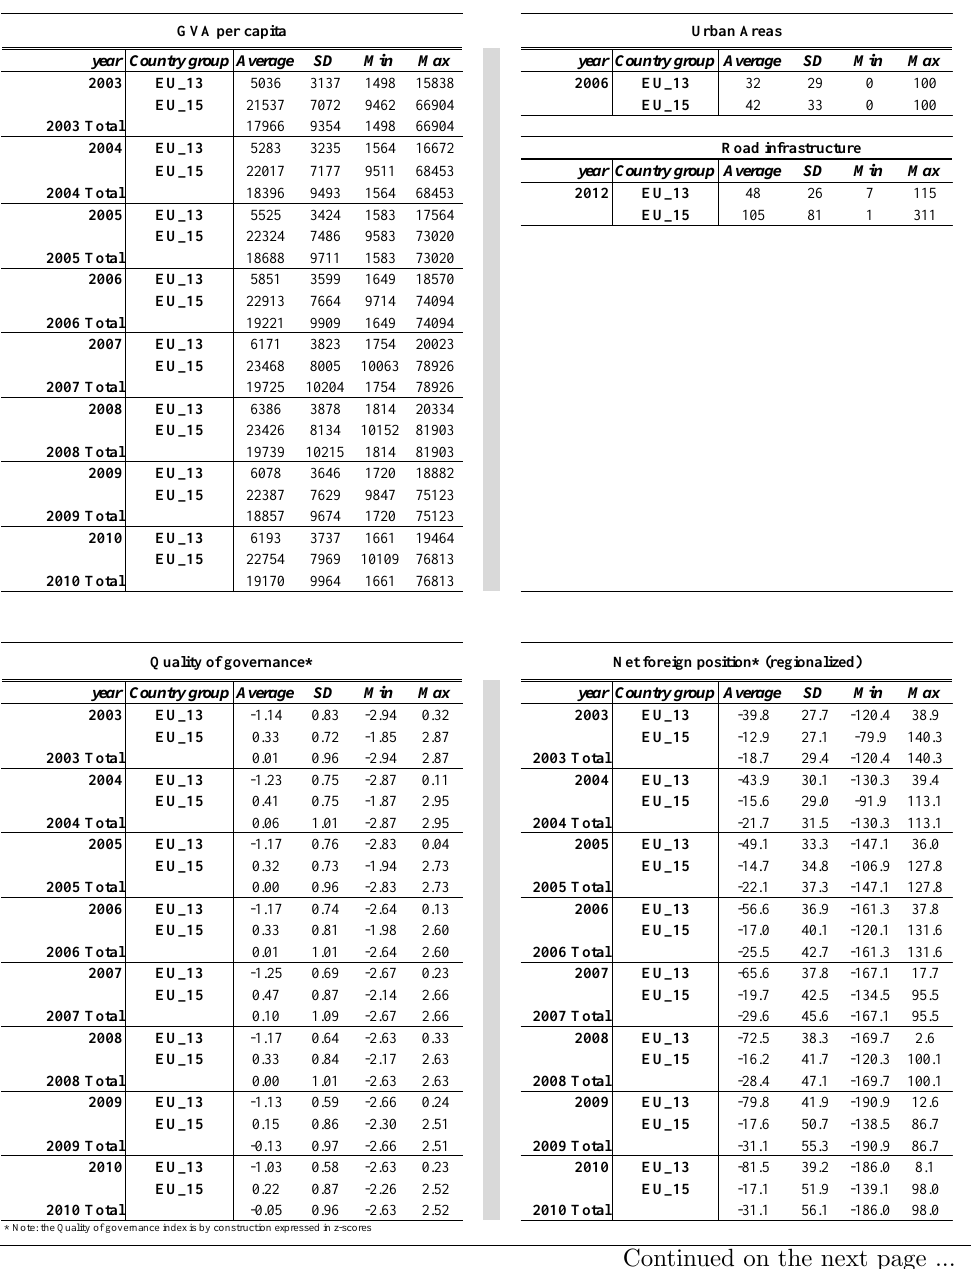
year Country group Average